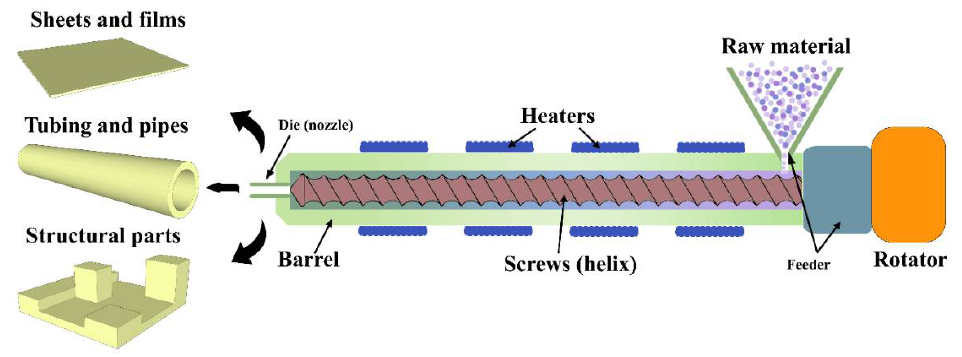
Figure 6. Schematic diagram of a polymer extrusion machine. The barrel and screw are the two major industrial components (redrawn from Ref. [225]).